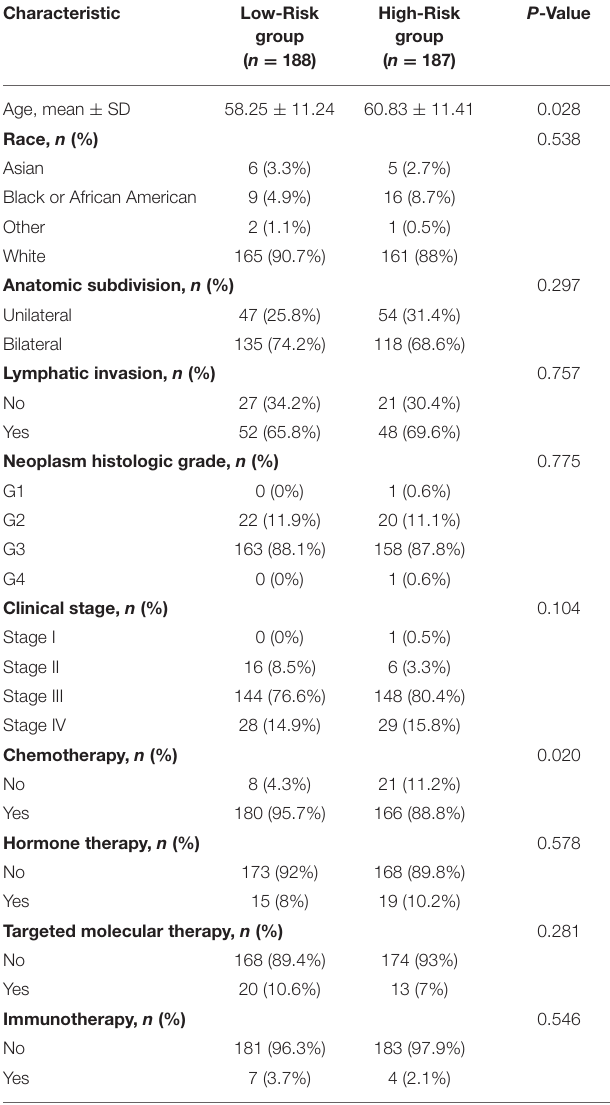
TABLE 6 | Associations between risk score and characteristics of patients with ovarian cancer.